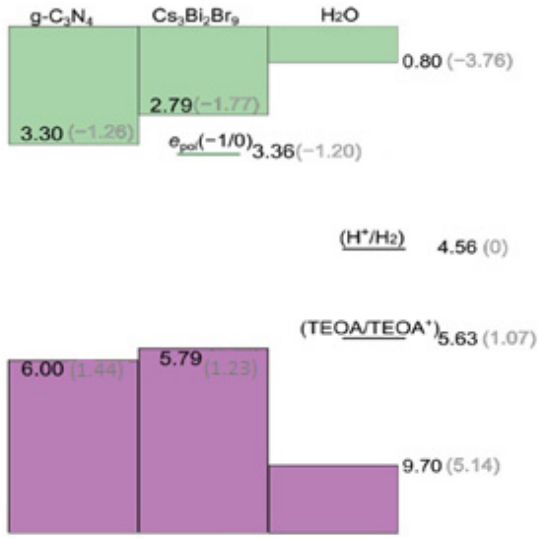
Figure 8. Valence band (VB) and conduction band (CB) edges of g-C 3 N 4 and Cs 3 Bi 2 Br 9 aligned with the band edges of liquid water and with the H + /H 2 and TEOA/TEOA + redox level through the vacuum level [3]. The ( − 1/0) charge transition level of the electron polaron calculated for Cs 3 Bi 2 Br 9 is also reported. Values are referred to the vacuum level (black) and to the standard hydrogen electrode (SHE, grey) using the computational alignment achieved in ref (Y. Fu, H. Zhu, 2019) [36].